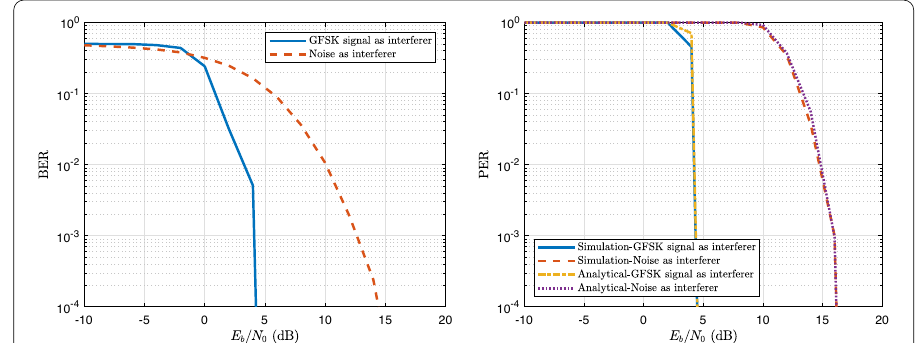
Fig. 6 BLE receiver immunity against GFSK modulated and AWGN interferences. Left: BER, right: